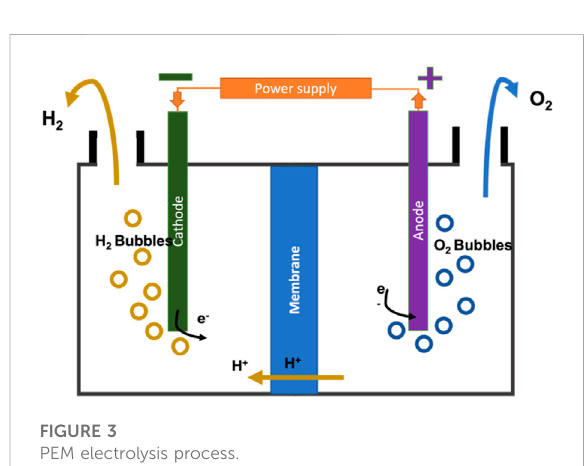
FIGURE 2 Alkaline electrolysis process.